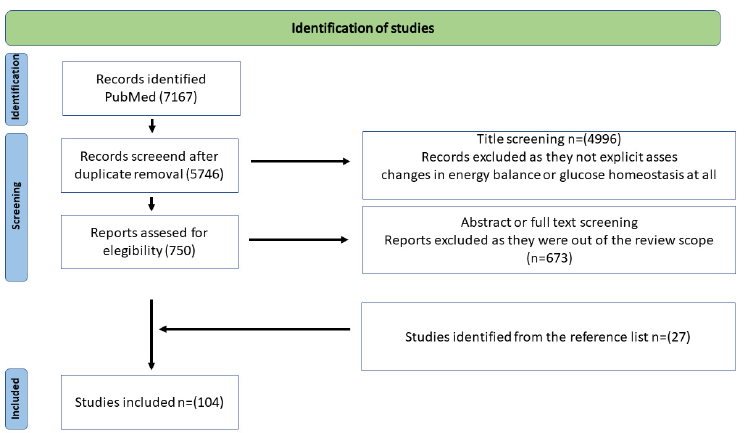
Figure 5. Flowchart of the study. ([“fibroblast growth factor 21” and “obesity”], [“fibroblast growth factor 21” and “feeding behavior”], [“fibroblast growth factor 21” and “liver”], [“fibroblast growth factor 21” and “brain”], [“fibroblast growth factor 21” and “Diabetes Mellitus, Type 2”], [“fibroblast growth factor 21” and “Non-alcoholic Fatty Liver Disease”], [“fibroblast growth factor 21” and “ad- ipose Tissue, Brown”], [“fibroblast growth factor 21” and “Thermogenesis”], [“fibroblast growth factor 21” and “blood glucose”], [“fibroblast growth factor 21” and “insulin resistance”], [“fibroblast growth factor 21” and “humans”]).